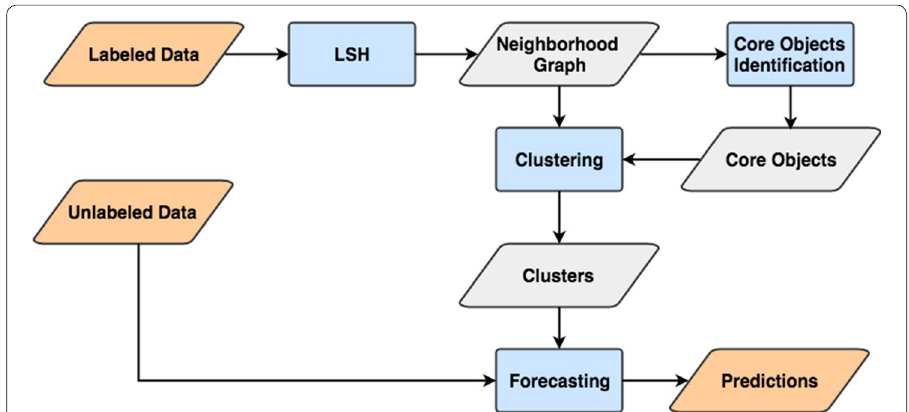
Fig. 2 Workflow of the proposed method. Orange blocks represent inputs (labeled and unlabeled objects) and outputs (predictions); grey blocks represent intermediate results; blue blocks represent the different phases of the proposed